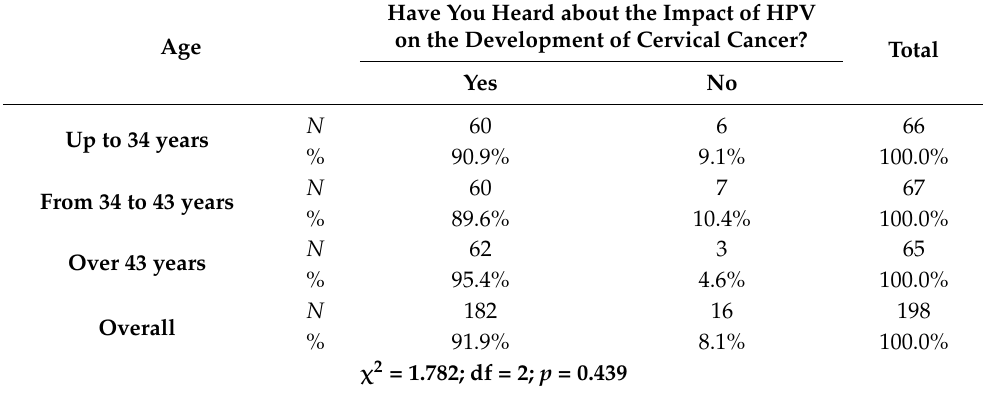
Table 2. Results from analyzing the relationship between the age of the respondents and the awareness of the impact of HPV on the development of cervical cancer. Have You Heard about the Impact of HPV on the Development of Cervical Cancer? Total Age Yes No N 60 6 66 Up to 34 years % 90.9% 9.1% 100.0% N 60 From 34 to 43 years % 89.6% 10.4%